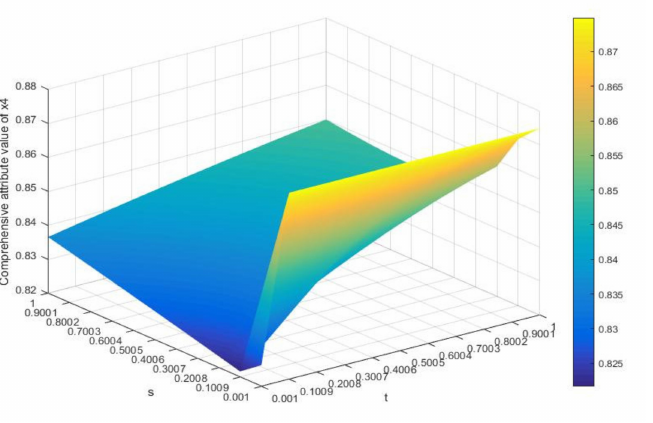
Figure 6. Comprehensive attribute values of x 4 obtained by the TPGWHM ( t , s ∈ [ 0.001,1 ]